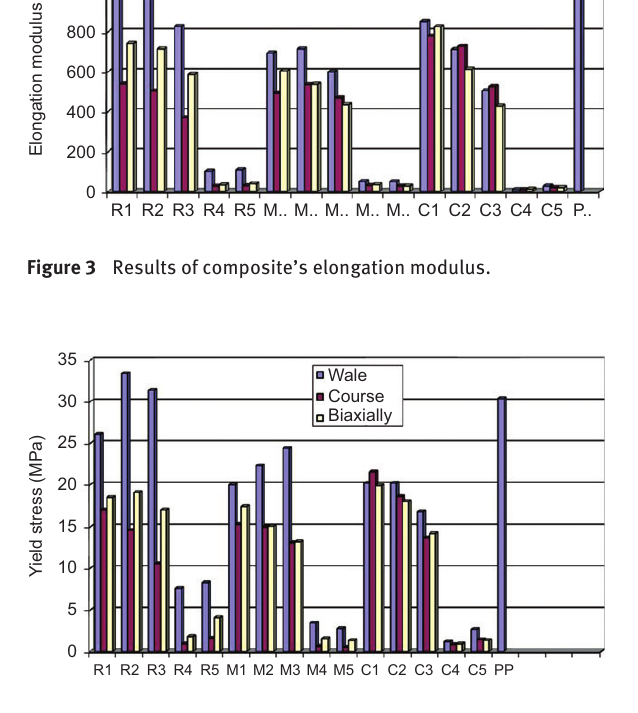
Figure 7 Results of composite ’ s break stress.